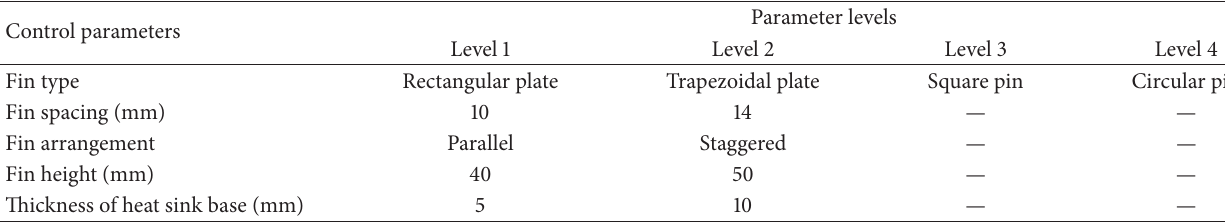
Table 1: Parameter and parameter levels of the novel fin heat sink.